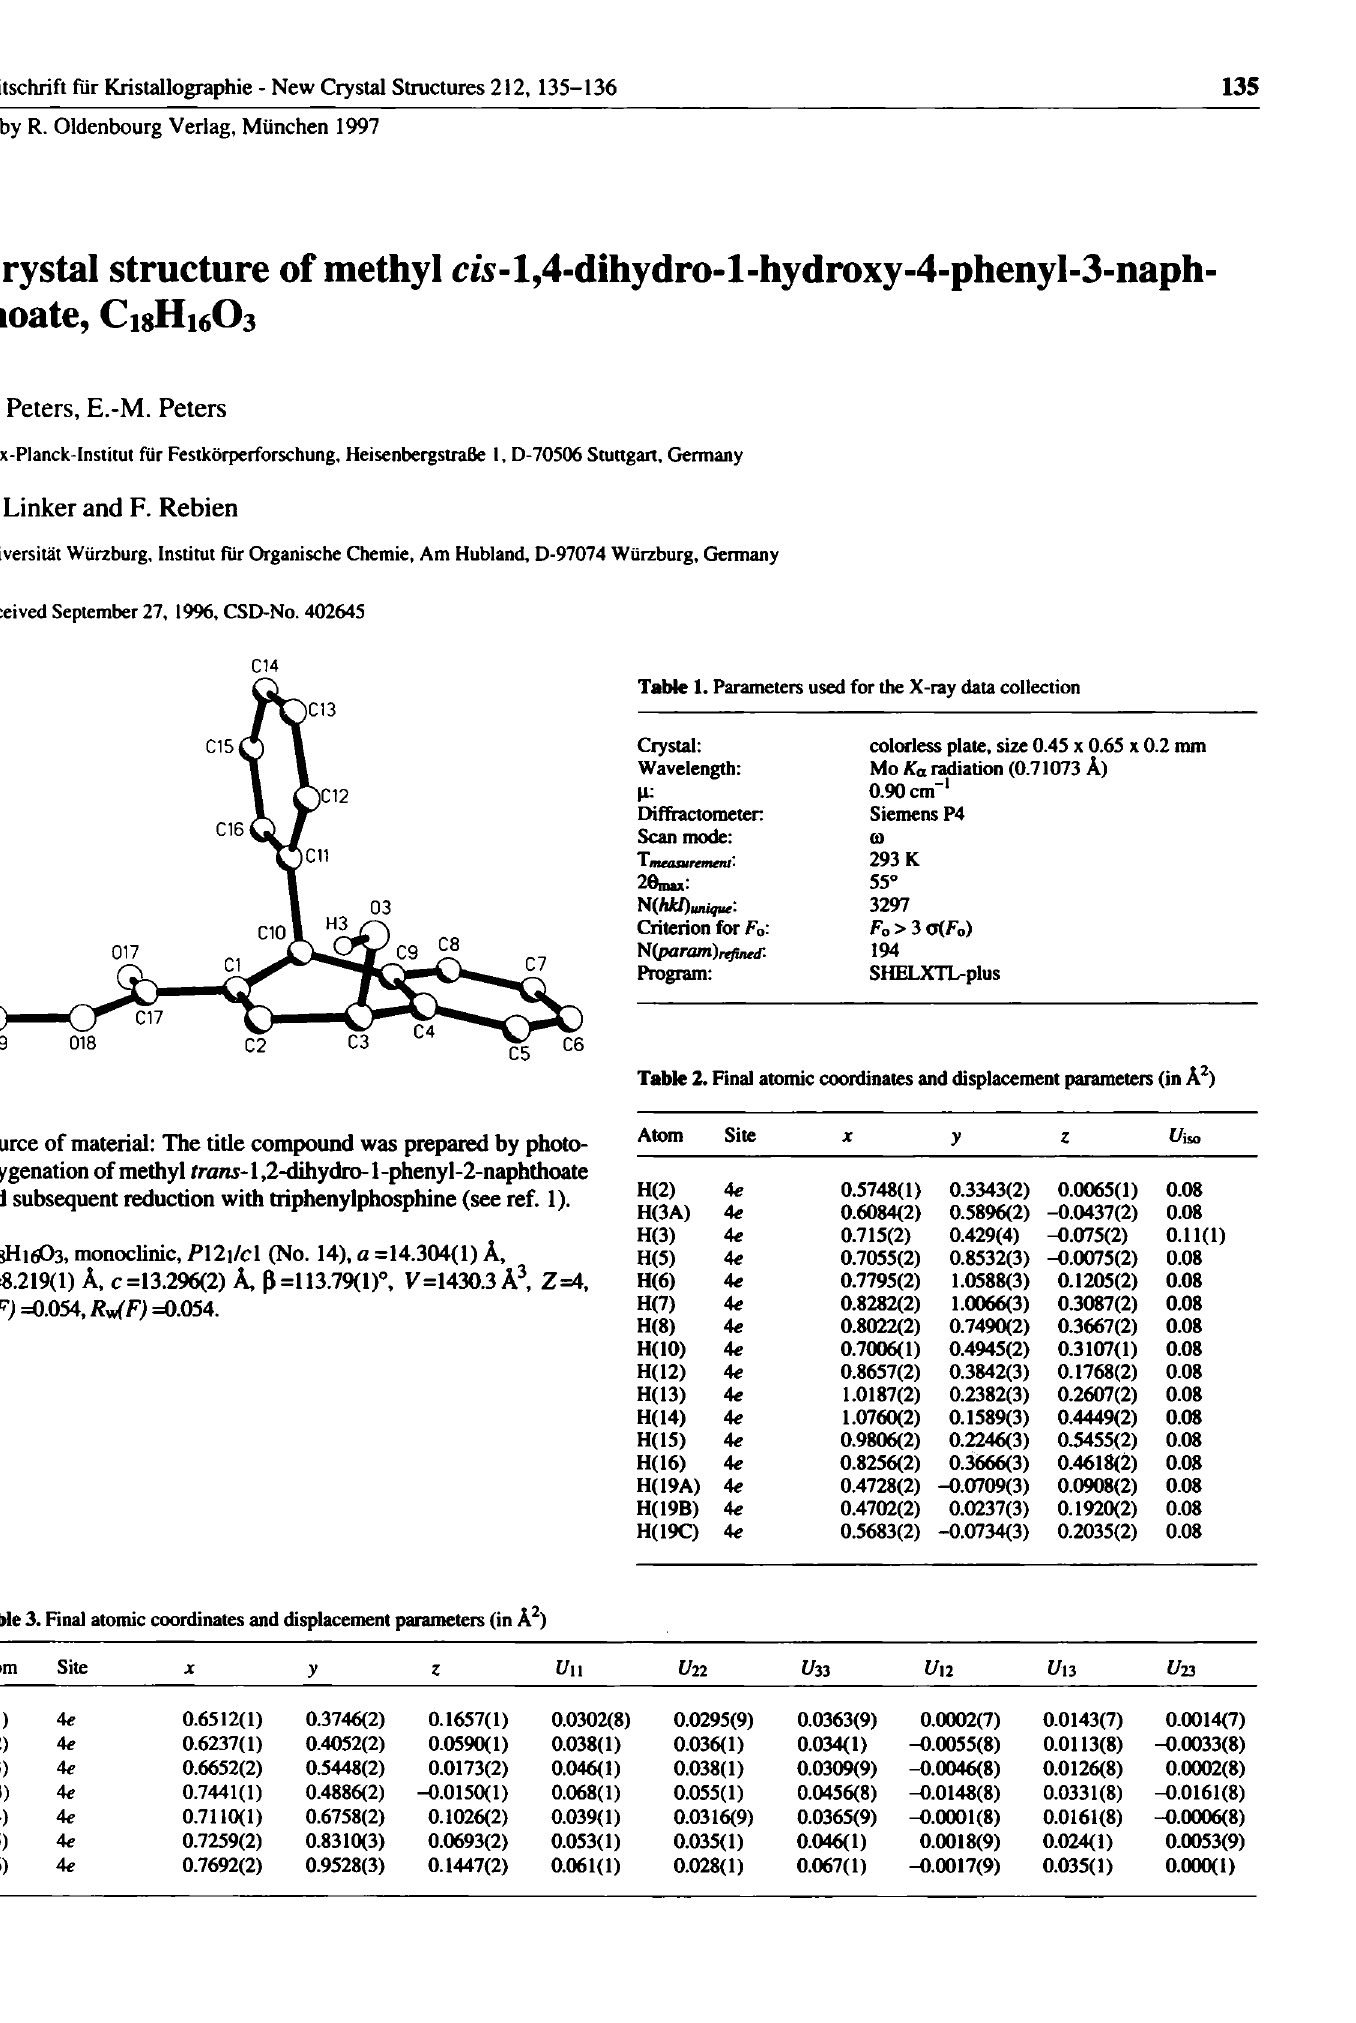
Table 3. Final atomic coordinates and displacement parameters (in Â 2 )